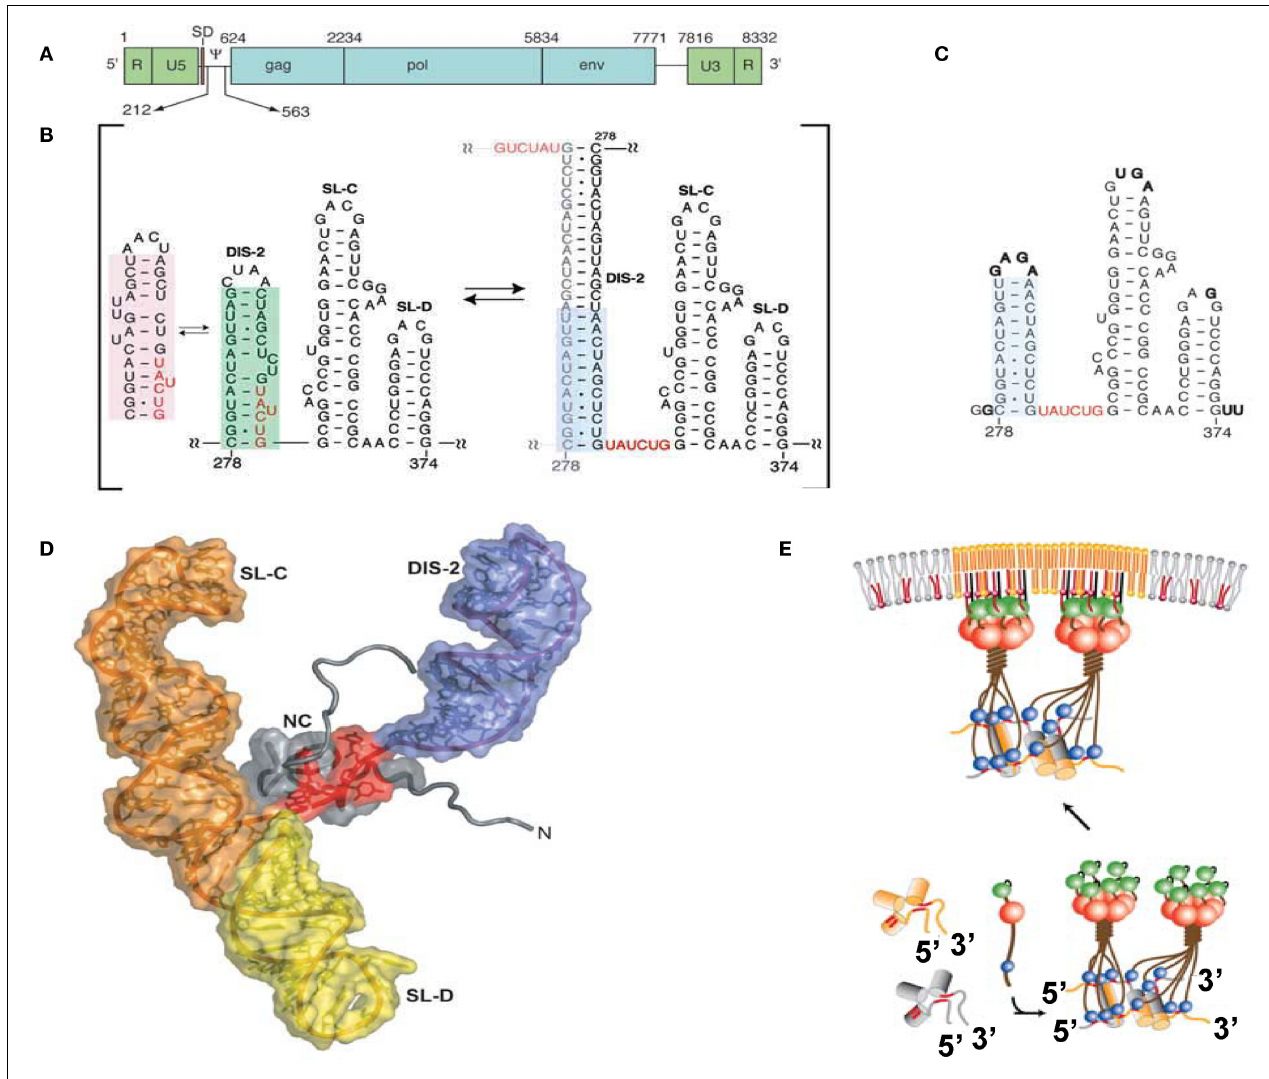
FIGURE 2 | (A) Genomic organization of MoMLV. (B) Secondary structure of the core encapsidation signal ( Ψ CES ). Dimerization of DIS-2 induces a frame shift, exposing a UCUG element as a linker. (C) Secondary structure of mutant Ψ CES that mimics the dimer-like conformation. (D) The complex of NC and mutant Ψ CES . (E) Hypothetical mechanism for the genome packaging of